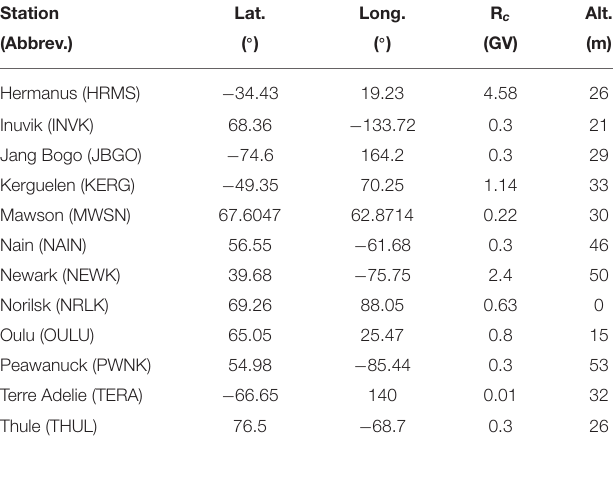
TABLE 1 | Details of NMs used in the analysis (data obtained from NMDB Database, http://www.nmdb.eu/nest). Station Lat. Long. R c Alt.